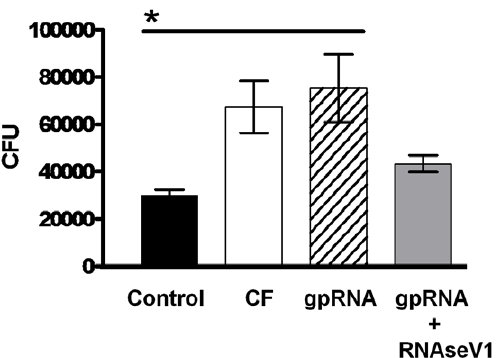
Figure 6. M.tuberculosis H37Rv RNA altered human monocyte’s ability to control M.tuberculosis infection. CFUs were determined for human monocytes infected with M. tuberculosis H37Rv and incubated for four days in the presence of 1 m g/ml of M. tuberculosis H37Rv CF, purified RNA (gpRNA), or purified RNA digested with RNaseV1 (gpRNA + RNaseV1). The presence of CF or gpRNA resulted in a significant increase in CFUs as compared to the untreated infected monocytes (Control). Data represent the mean 6 SEM of 3 replicates of the same experiment (*p , 0.03).